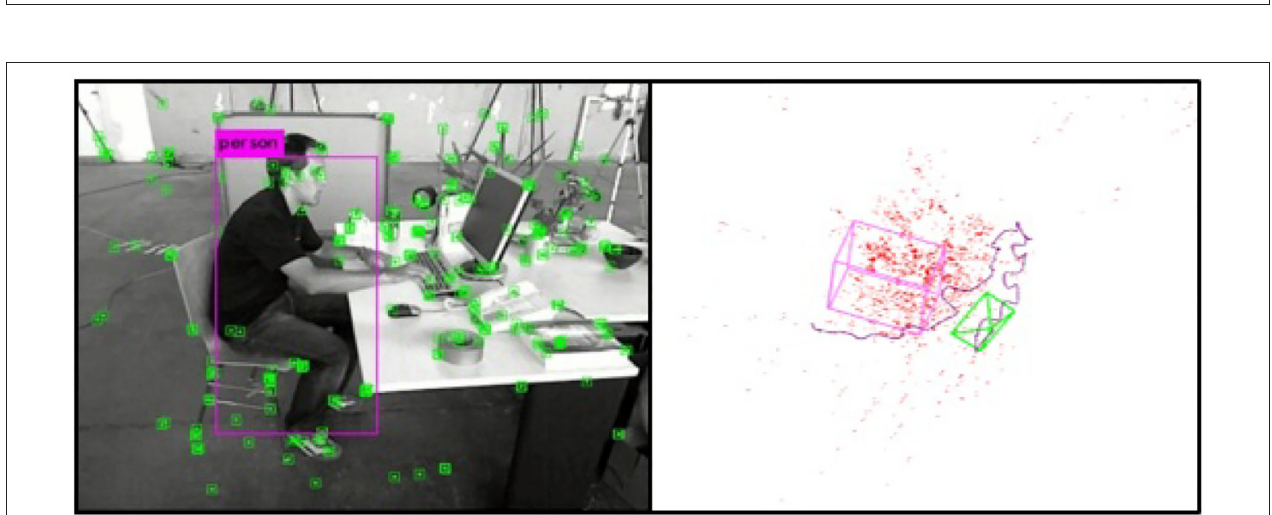
FIGURE 11 | Estimation results of the object spatial position.